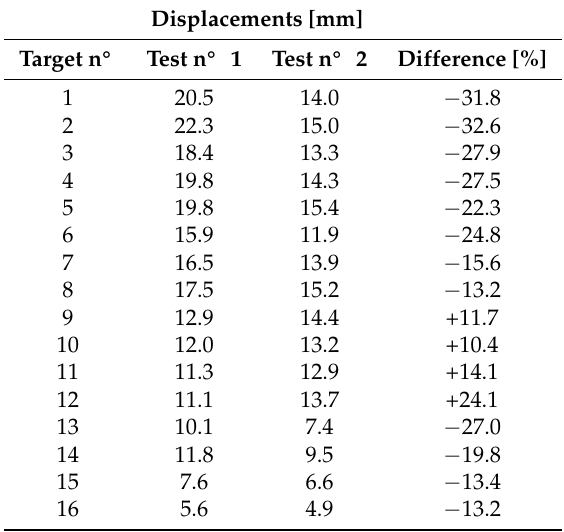
Table 3. Displacements of the 16 targets measured with the total station for test n° 1 and 2. Averaged values on three repetitive measurements for each load